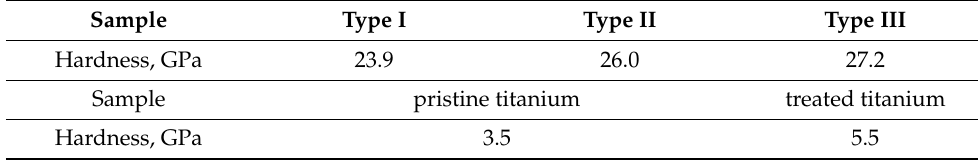
Table 2. Average value of the microhardness of the samples treated in different